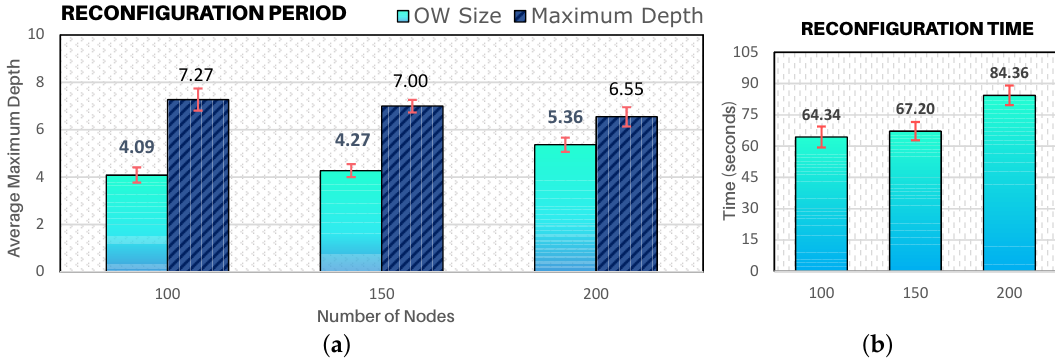
Figure 16. Reconfiguration time. ( a ) The ratio of the number of BIs in the Opportunity Window under the maximum network depth; ( b ) the respective time in seconds.